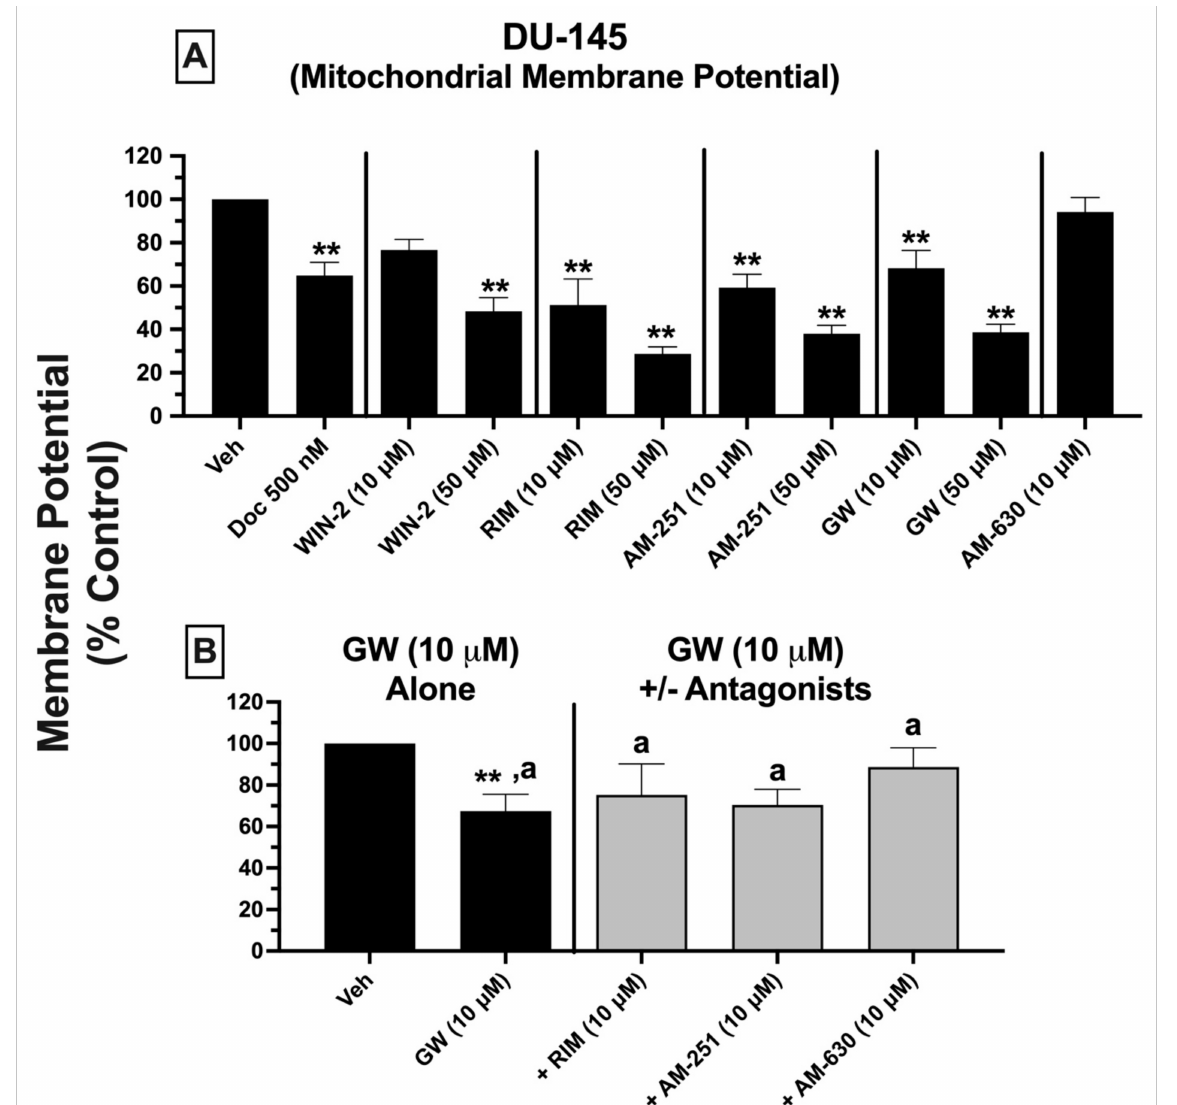
Figure 9. Mitochondrial membrane potential (MMP): ligands exhibiting high affinity for expressed CBRs in DU-145 cells induce significant mitochondrial depolarization, indicative of disruption in mitochondrial function. Mitochondrial membrane potential (MMP) was assessed using JC-1 staining and reading the plate using a SpectraMax M2e microplate reader following 24 h incubation of DU-145 cells with CBR ligands. ( A ) MMP was measured 24 h after treatment of cells with a lower (10 µ M) and higher (50 µ M) concentration of CBR ligands when administered alone. ( B ) To determine whether reductions in MMP produced by GW-405833 could be antagonized by lower concentrations of CBR ligands producing little or no MMP reduction when tested alone, the effect of MMP was measured following co-incubation of GW-405833 (10 µ M) with (10 µ M of) each CBR ligand examined. Significantly different from 100% (one-sample t -test, ** p < 0.01). a Compounds designated with different letters are significantly different from each other (one-way ANOVA followed by Tukey’s post hoc test for multiple comparisons, p <